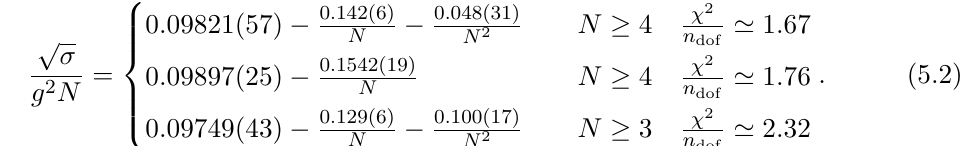
Figure 21 . Lattice values of SO(16) in ascending order, with continuum